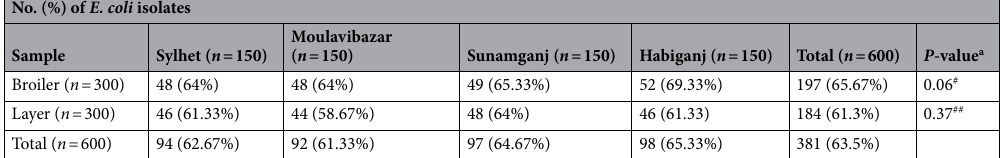
Table 2. Prevalence of E. coli in broiler or layer chicken meat swab specimens, collected from various retail shops at Sylhet division. a P values were calculated using a two-way analysis of variance (ANOVA) without replication. P values > 0.05 were considered to be statistically nonsignificant. # Variance between broiler and layer chickens. ## Variance among the four districts under study.